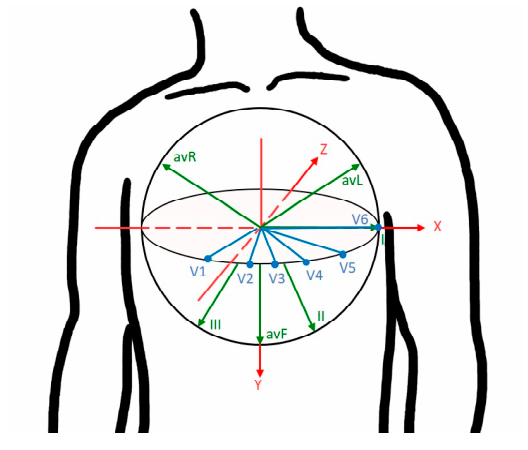
Figure 1. The three-dimensional view of 12 ECG leads on the xyz-coordinate axis system. MI is also known as a silent heart attack that usually occurs without clear